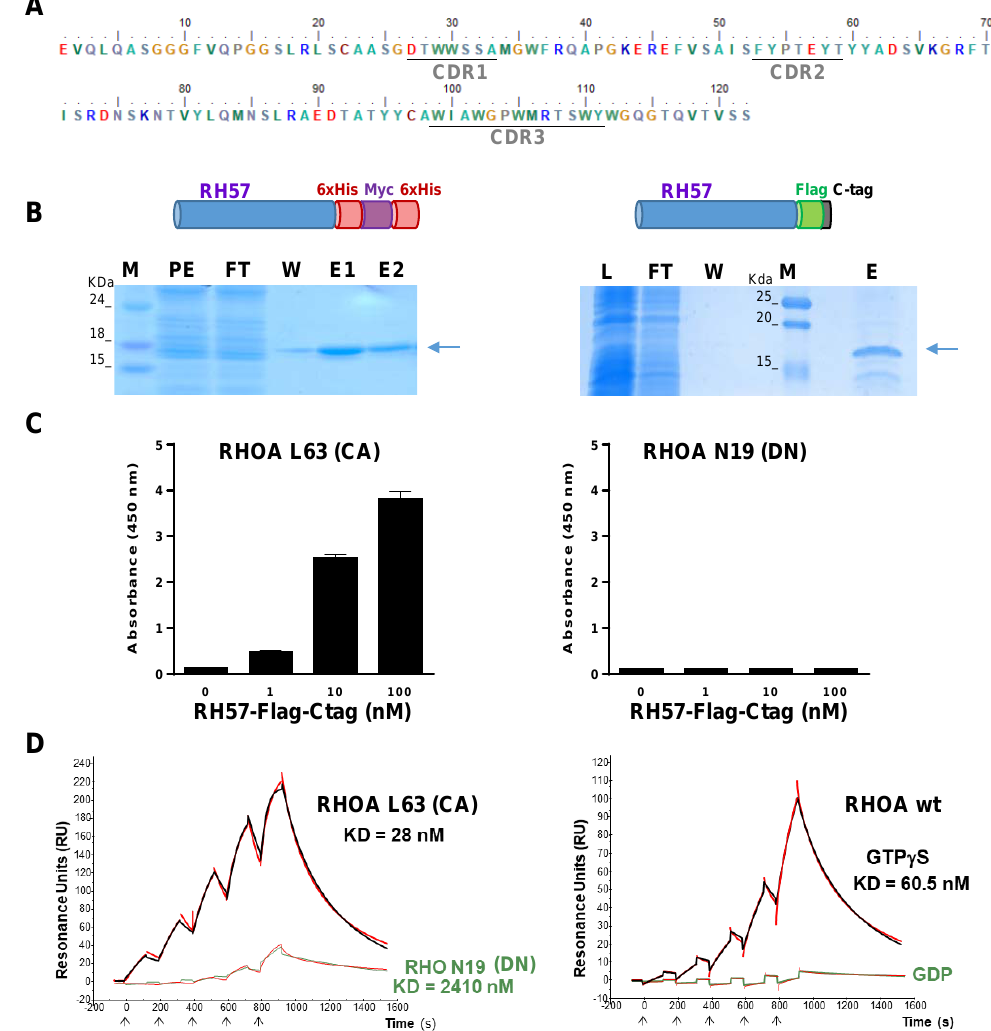
Figure 2. In vitro characterization of recombinant RH57 hs2dAb. ( A ) Amino acid sequence of the RH57 hs2dAb. Complementary-determining region (CDR) are underlined. ( B ) Representative Coomassie staining of SDS-PAGE showing the purification of RH57 fused to its carboxy terminal end with 6xHis-Myc-6xHis tag expressed in the periplasm (left) or RH57 fused to its carboxy terminal end with Flag tag and C-tag (right) used in the study. PE = periplasmic extract, L = clarified lysate, FT = flow through, W = wash, E = elution, and M = molecular weight marker. (C) ELISA detection of recombinant RHOA L63 constitutively active (CA) mutant versus RHO N19 dominant negative (DN) mutant. RHO proteins were captured on a Strep-Tactin coated plate and incubated with increasing concentrations of recombinant RH57-Flag-Ctag. Anti-Flag antibody was used to reveal the bound fraction of recombinant RH57 hs2dAb. (D) Single cycle kinetics (SCK) surface plasmon resonance (SPR) measurements on RH57-6xhis-myc-6xhis captured on an Ni-NTA (Nickel affinity capture of 6xHis) chip. Red lines correspond to the raw data measurements, and the fit curves are displayed in black or green according to the condition. Analytes were recombinant RHOA L63 CA mutant (black line, left SCK); RHOA N19 DN mutant (green line, left SCK); or RHOA WT loaded with either GTP γ S (black line, right SCK) or GDP (green line, right SCK), injected at increasing concentrations (arrows, see